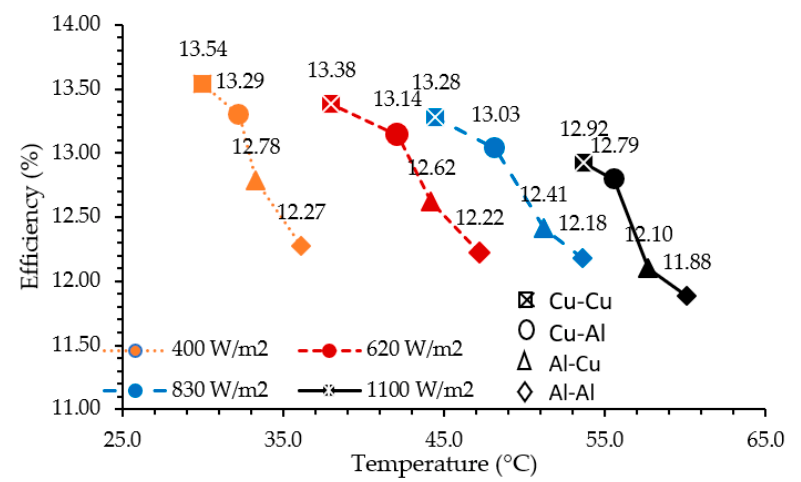
Figure 12. Efficiency vs. temperature change.